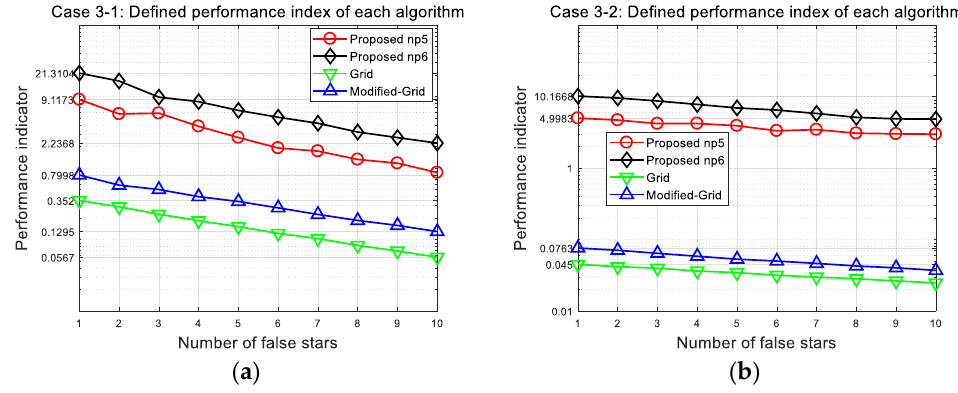
Figure 15. Performance index of each algorithm at 150 arc-seconds position error: ( a ) Case 3-1 indicates performance with narrow FOV; ( b ) Case 3-2 indicates performance with wide FOV. Table 12. Defined performance index at 150 arc-seconds position error with 10 false stars.